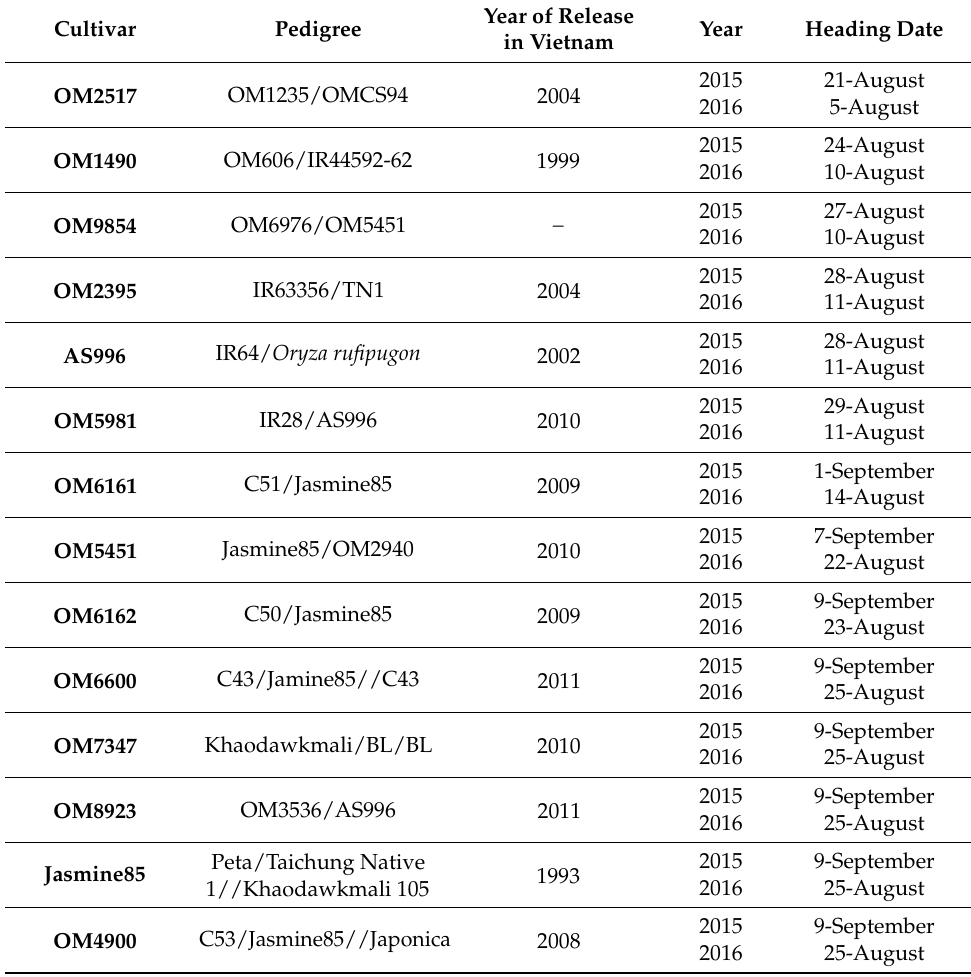
Table 4. Details on the pedigree and heading date of Vietnamese cultivars in 2015 and 2016 at Okayama,